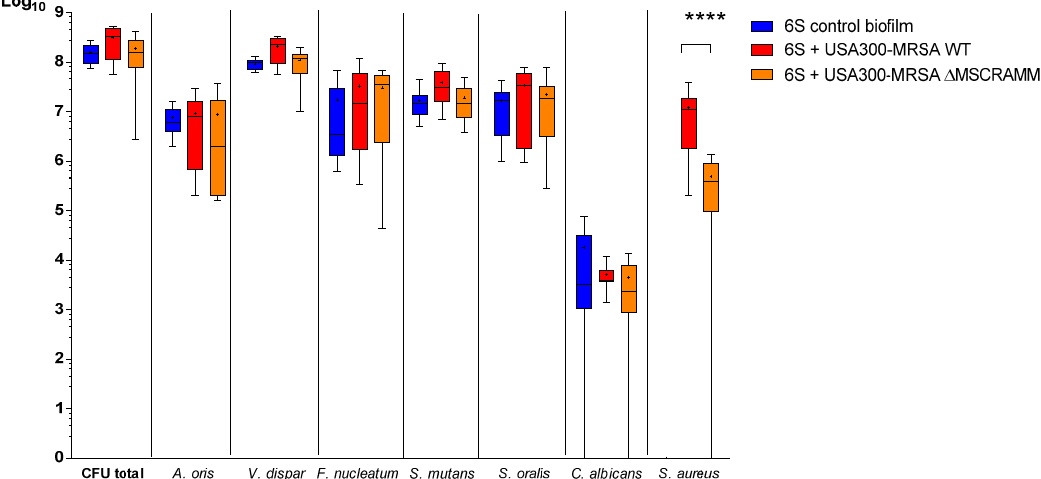
Figure 2. Boxplots with median and interquartile ranges showing the influence of S. aureus MSCRAMM on the growth of S. aureus in multispecies oral biofilms. Quantification was performed using species-specific culture analyses. The 6S control biofilms are presented in blue, the 6S + WT (implemented the wild type S. aureus strain) is presented in red, and the 6S+ Δ MSCRAMM (implemented the MSCRAMM-deficient S. aureus strain) in orange. The data are expressed as the mean ± SD of bacterial counts from 9 biological replicates, presented on a log 10 scale per milliliter. ANOVA test: **** p < 0.0001.